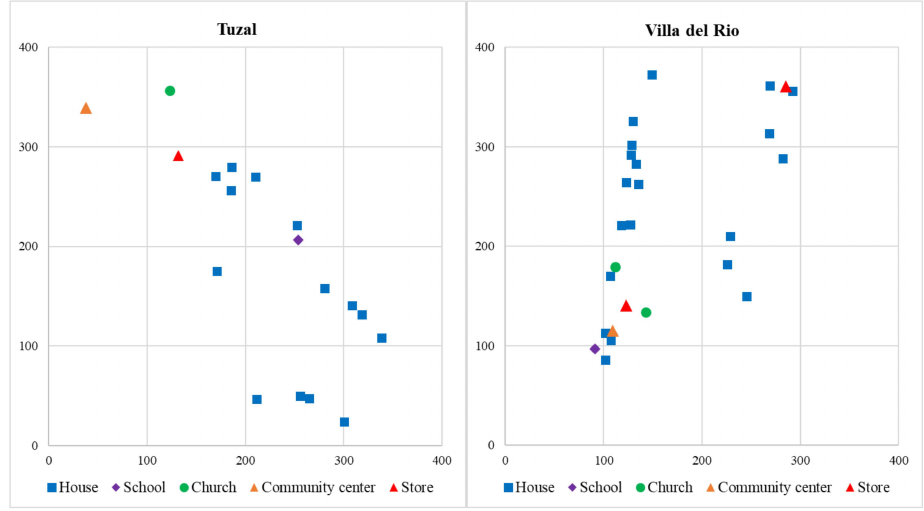
Figure 3. Layout of the Mexican communities.